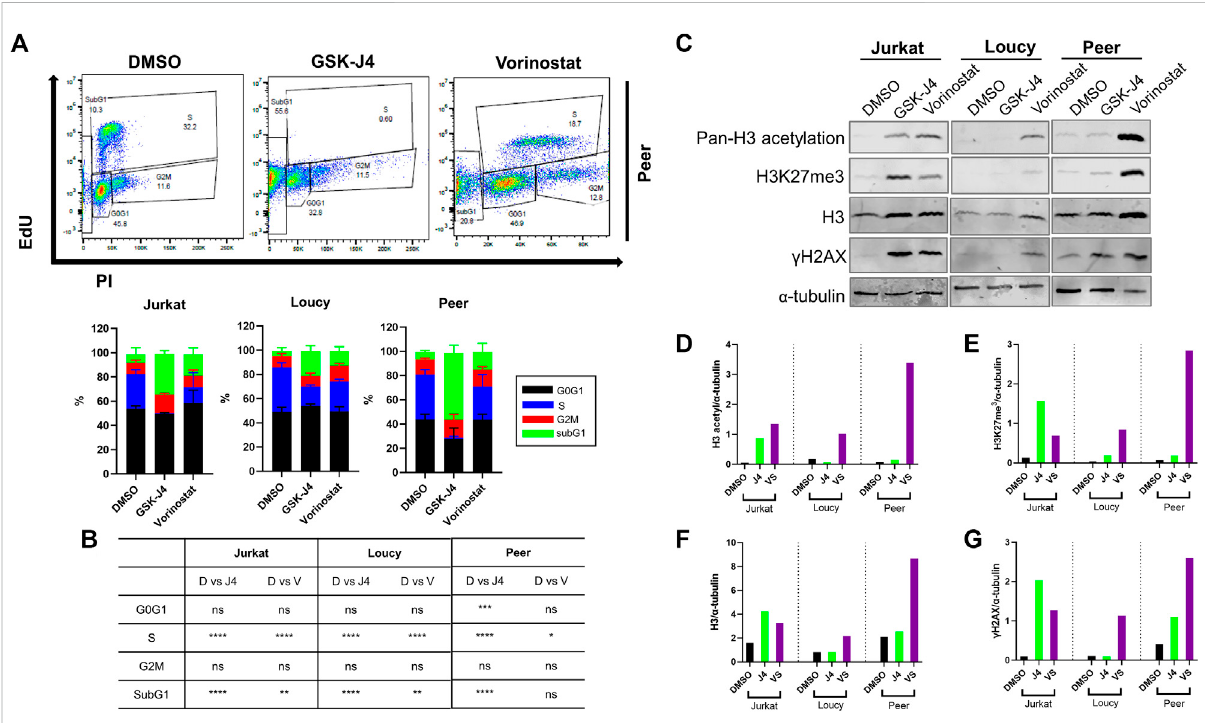
FIGURE 5 Epigenetic modifying drugs phenocopy cell cycle and epigenetic changes induced by ACM in human T-ALL cells. Human T-ALL cells (Jurkat, Loucy, andPeer)weretreated withDMSO (control),GSK-J4(ahistone demethylaseinhibitor),orvorinostat (ahistone deacetylase inhibitor) for72 h, and cell cycles were assessed using EdU analysis and fl ow cytometry. (A) Representative primary data from three independent experiments (top panel) and (B) cell cycle distribution data (bottom panel) from thecombined experiments are shown. (C) Cells treated in (A) were processed for Western blot analysis to determine the levels of modi fi cations on histone 3 (H3), total H3 levels, and indicators of genotoxic stress ( γ H2AX). (D – G) ProteinexpressionlevelsfromtheWesternblotexperimentsweredeterminedusingImageJanalysisandarepresentativeblotfromtwoindependent experiments is